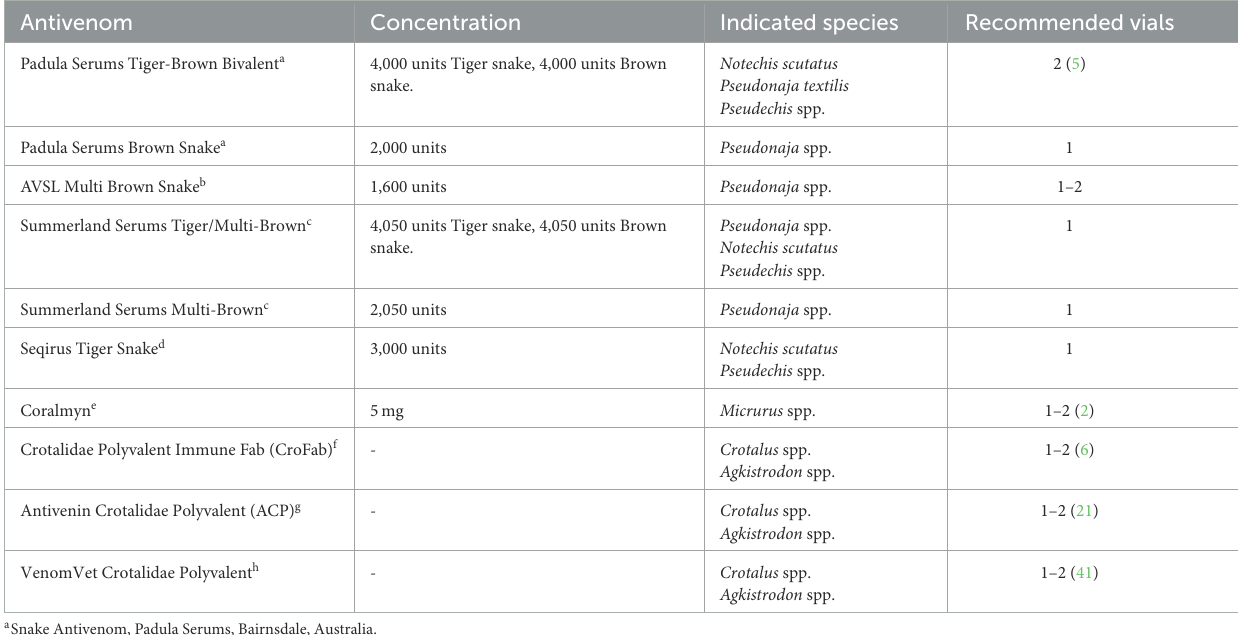
TABLE 1 Commercially available antivenom therapies. Antivenom Concentration Indicated species Recommended vials Padula Serums Tiger-Brown Bivalent a 4,000 units Tiger snake, 4,000 units Brown Notechis scutatus snake. Pseudonaja textilis Pseudechis